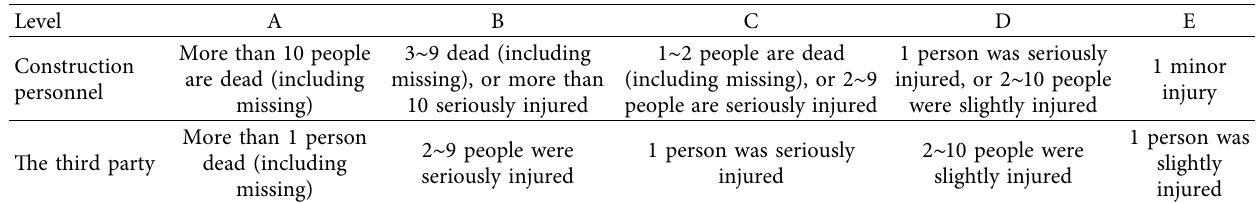
Table 4: Standard for casualty rating of construction personnel and third parties.